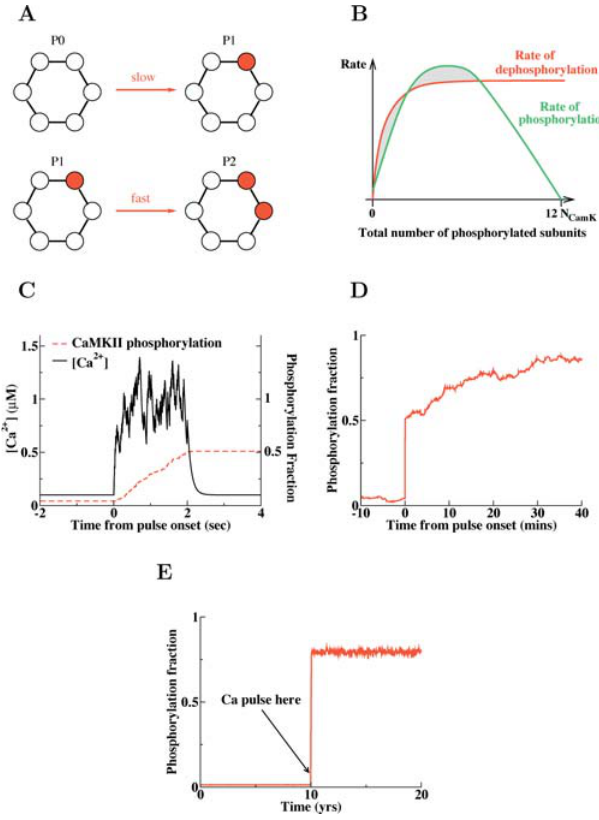
Figure 1. CaMKII Autophosphorylation and PP1 Saturation Lead to Bistability in the Phosphorylation States of CaMKII at Resting Ca 2 þ (A) Phosphorylation of the first subunit is slow at resting Ca 2 þ because of the requirement for two Ca 2 þ /calmodulin molecules (see text). Subsequent phosphorylation is faster because only one Ca 2 þ /calm- odulin is required. (B) Schematic figure indicating how bistability arises from the dependence of phosphorylation and dephosphorylation rates on the number of subunits phosphorylated. Stable states are at the left (DOWN) and right (UP) intersections of the two curves. The middle crossing is unstable. The greater the area of the shaded region between a stable steady state and the unstable steady state, the harder it is for fluctuations to destabilize that stable steady state (the larger their basins of attraction). (C) A 2-s pulse of high Ca 2 þ switches the system (with 16 holoenzymes) from a low state of phosphorylation to a higher state within the basin of attraction of the UP state (see [D]). Phosphorylation fraction is Sp tot /12 N CaMK . (D) After the end of the Ca 2 þ pulse, it can take tens of minutes for the system to reach the dynamic equilibrium in the UP state. (E) The UP state is stable for many years in a system with 16